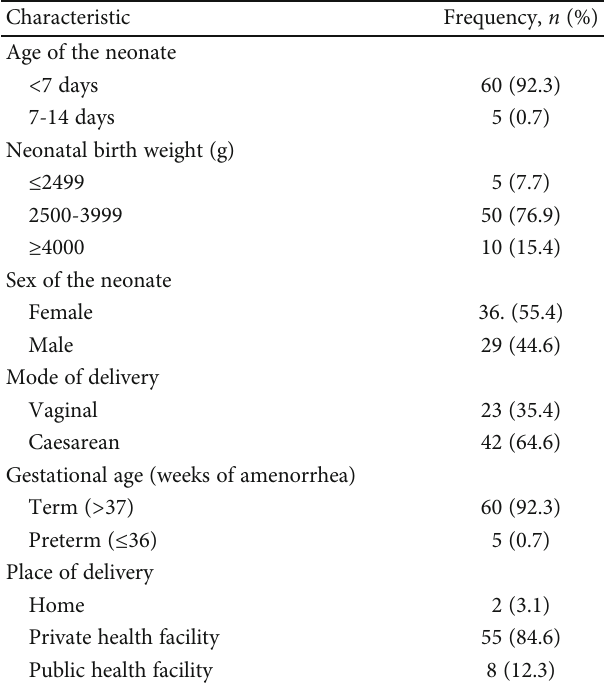
Table 1: Perinatal characteristics of neonates diagnosed of